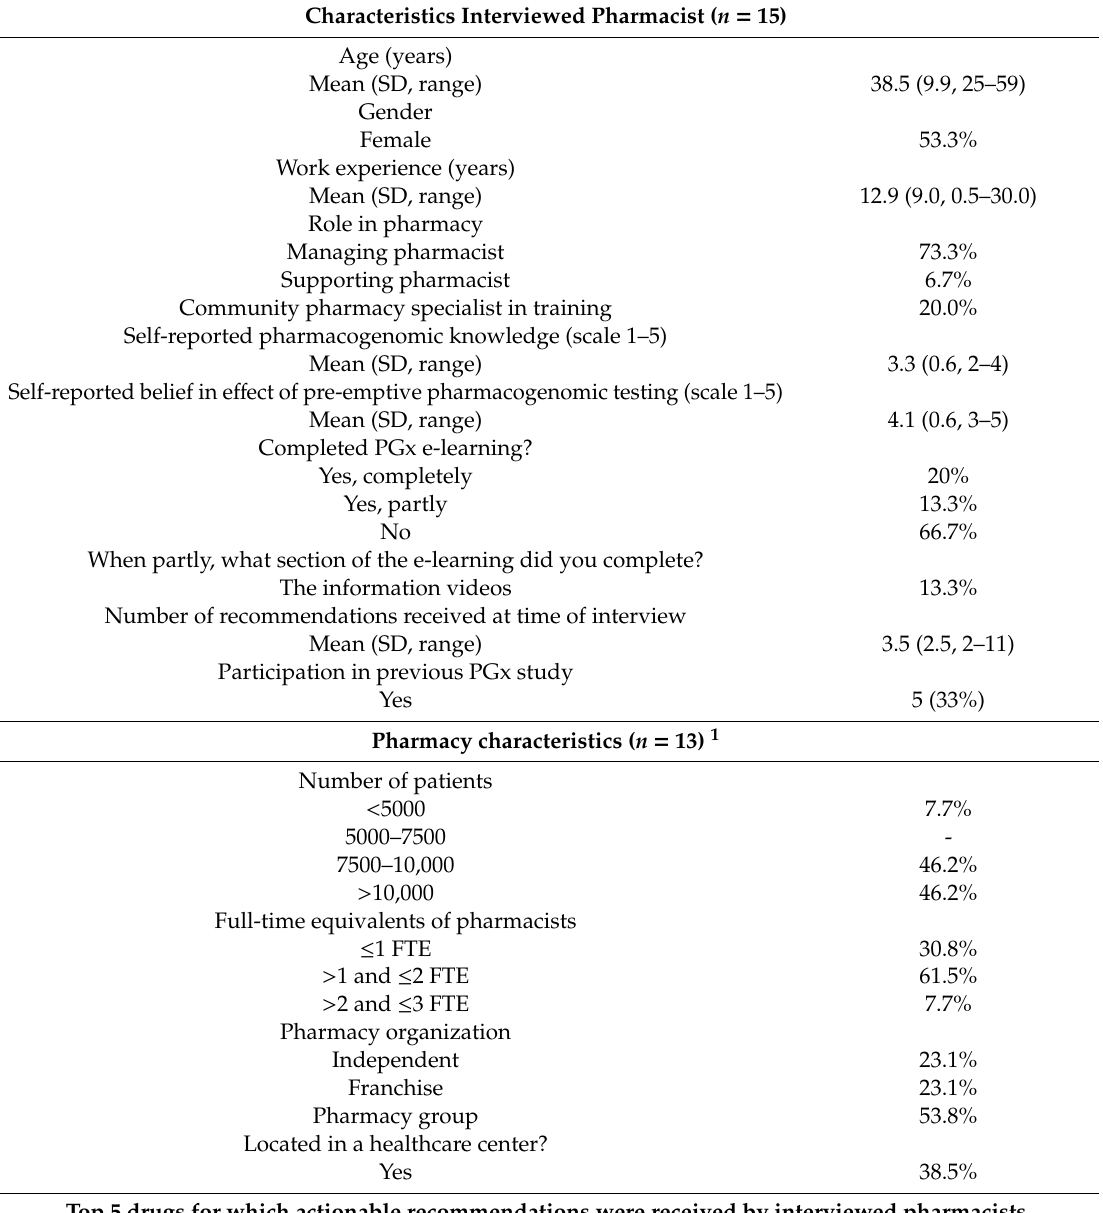
Table 1. Demographics of interviewed pharmacists, their pharmacies and the drugs, for which actionable recommendations were received before being